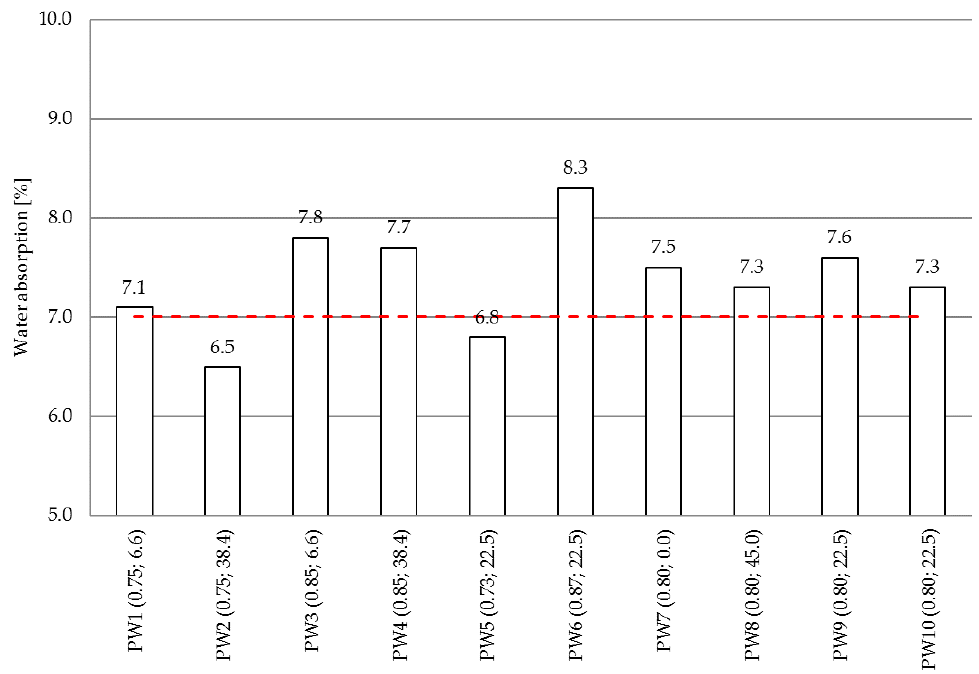
Figure 4. Water absorption of the tested concrete mixes.